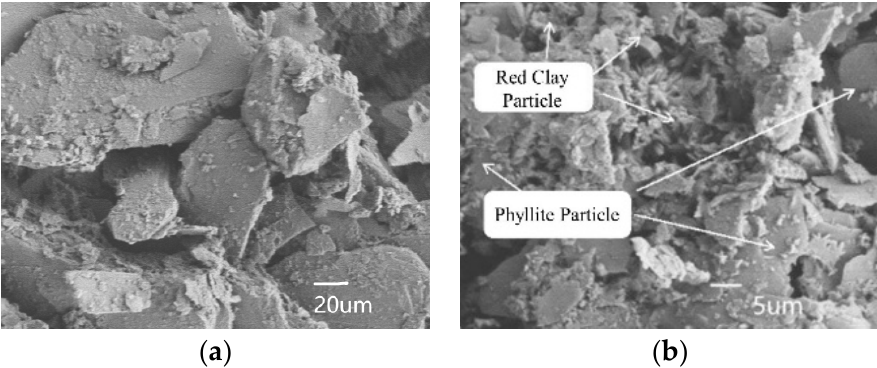
Figure 13. Microstructure of phyllite soil improved by red clay ( a ) λ = 0 and ( b ) λ = 40%.